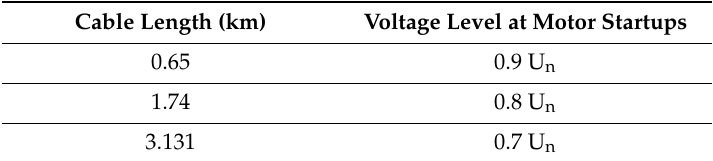
Table 5. Cable length values used in further calculations to obtain the selected motor terminals voltage levels.